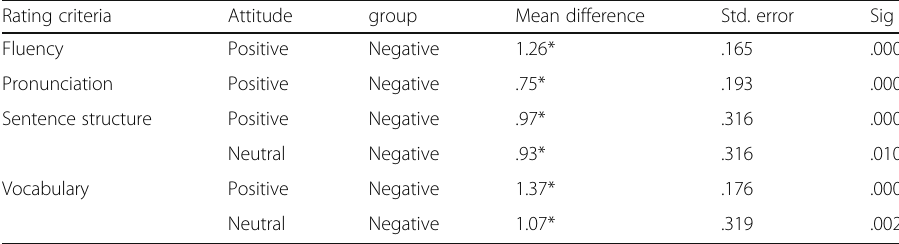
Table 4 Tukey multiple comparisons of four analytic scores awarded by different attitude groups Rating